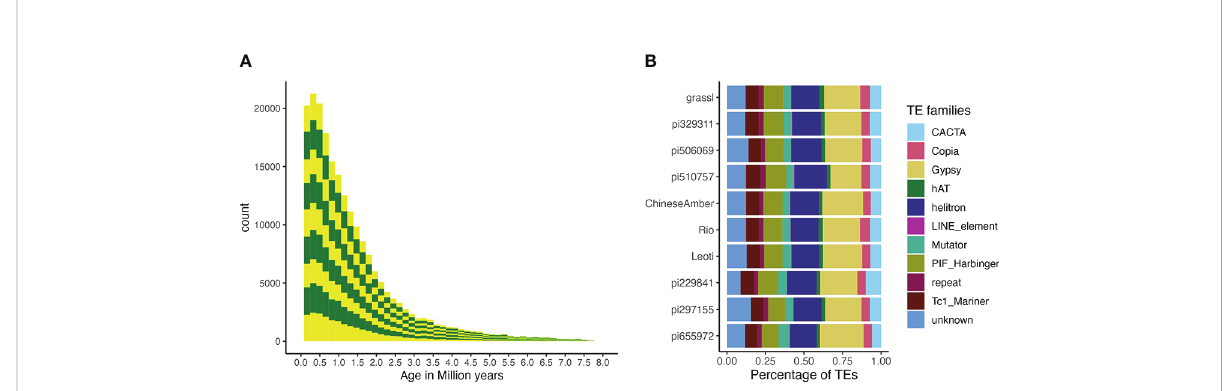
FIGURE 5 TE age and composition. (A) A stacked bar plot describing the distribution of TE counts by age across all genotypes. Alternating colors indicate different genotypes, and distributions are stacked in the order of the labels in fi gure 5b (i.e., the bottom yellow distribution shows the TE age frequencies for pi655972, while the top shows the distribution for Grassl)., T he Y-axis is number of TEs and the X-axis is their age in millions of years. (B) The proportion of superfamilies of TEs based on average counts of each superfamily across all